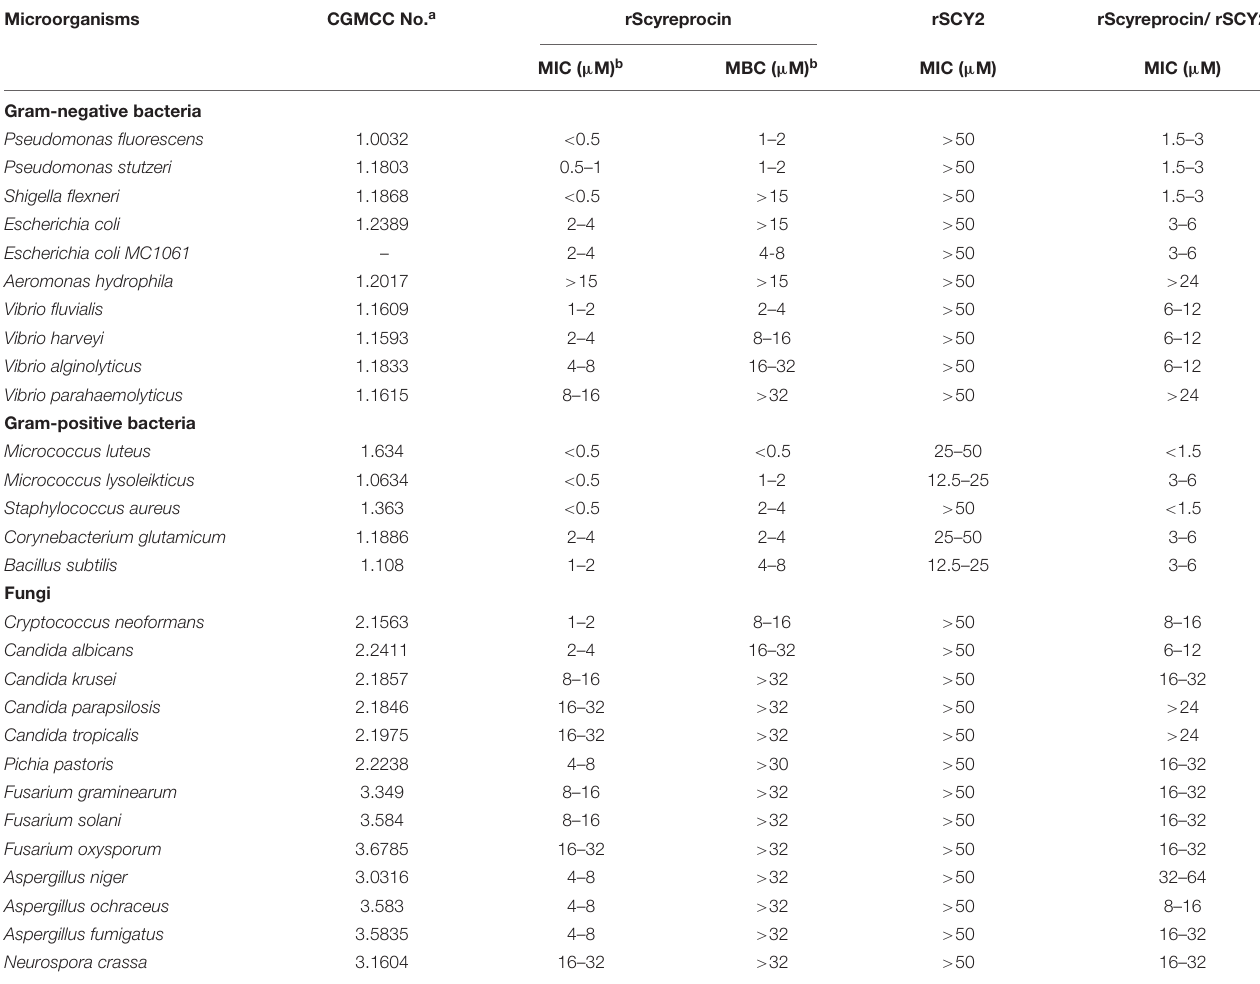
TABLE 1 | Antimicrobial activity of rScyreprocin, rSCY2, and rScyreprocin/rSCY2.